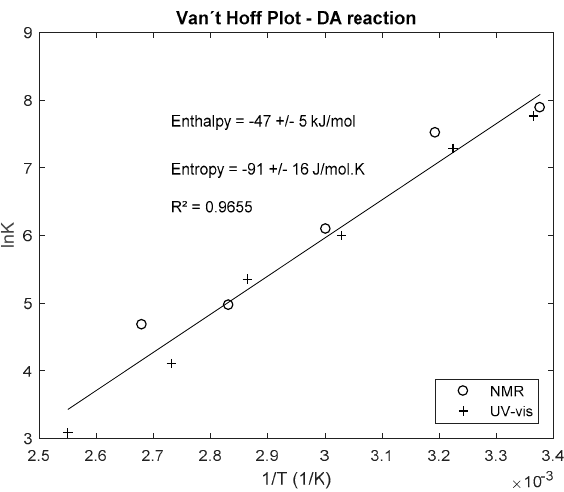
Figure 4. Van ’t Hoff plot for reaction FAL–NHM. Figure 4. Van ’t Ho ff plot for reaction FAL–NHM.